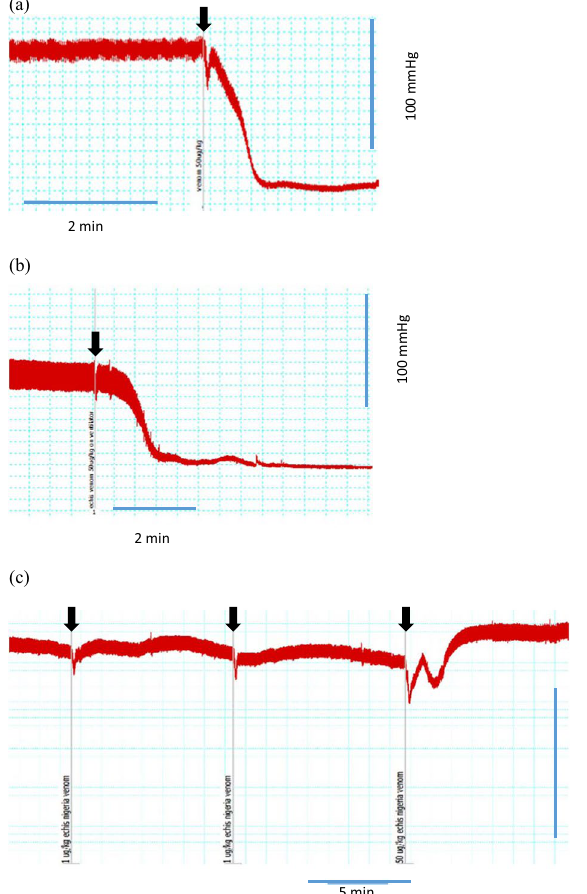
Figure 1. Traces showing rapid cardiovascular collapse induced by E. ocellatus venom (50 µ g/kg, i.v.) in anaesthetised rats in the ( a ) absence and ( b ) presence of artificial respiration. (c) Trace showing the response to E. ocellatus venom (50 µ g/kg, i.v.) after two sequential priming doses of E. ocellatus venom (1 µ g/kg, i.v). Venom additions indicated by